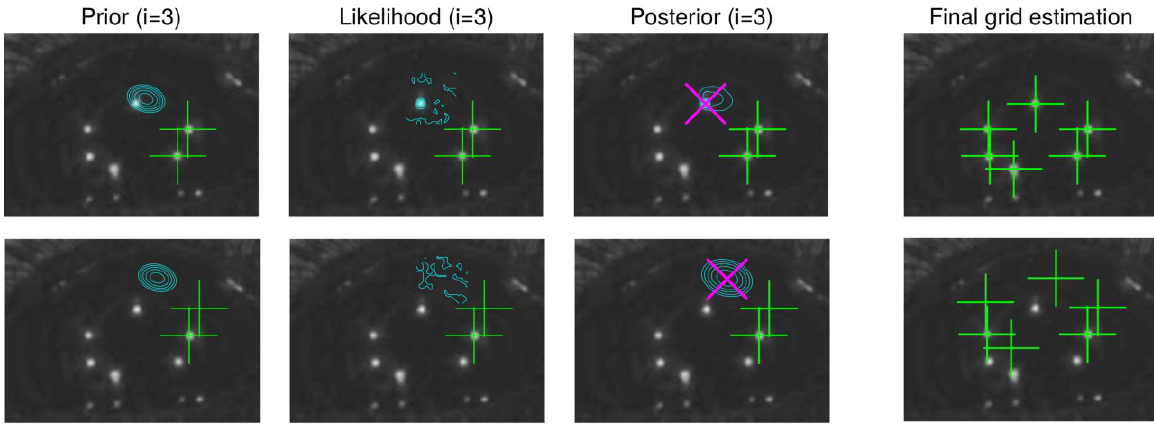
Figure 9. An illustrative example of the MAP estimation. Two particles are shown, in top and bottom rows. In the three leftmost panels, both particles have estimated two components, whose locations are marked with green plus signs, and are estimating their third component. The particle in the top row seems to be estimating the grid compo- nents in correct order whereas the other particle in the bottom row has a false order. The panels from left to right show respectively the contours of the prior distribution, likelihood, and posterior distribution of the third component. The distributions are evaluated only in the vicinity of the prior mean. The MAP estimate is marked with a magenta cross. The rightmost panels show the final grid estimation of the particles. The maximum of the joint posterior of the top particle is likely to greatly exceed that of the bottom row so if only these two particles were in use, the estimated glint grid location would be that of the top row particle.